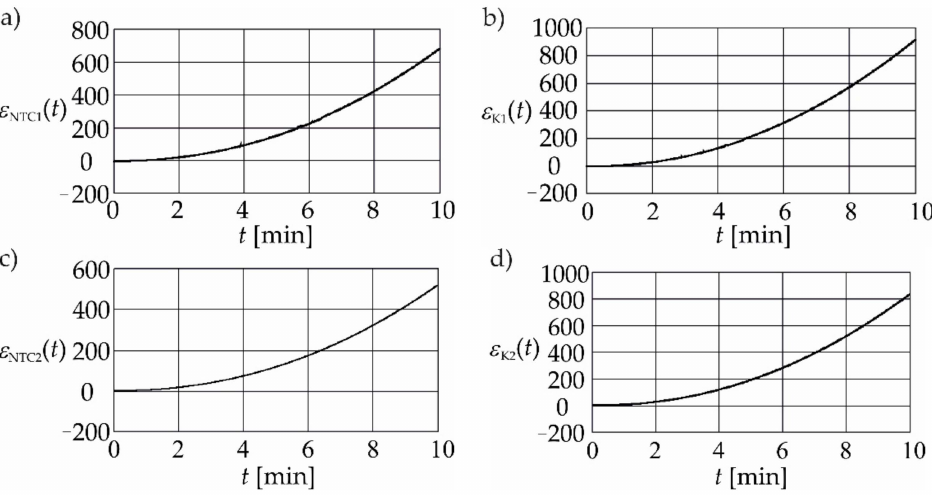
Figure 8. Errors ε NTC1 ( t ) ( a ), ε K1 ( t ) ( b ), ε NTC2 ( t ) ( c ) and ε K2 ( t ) ( d